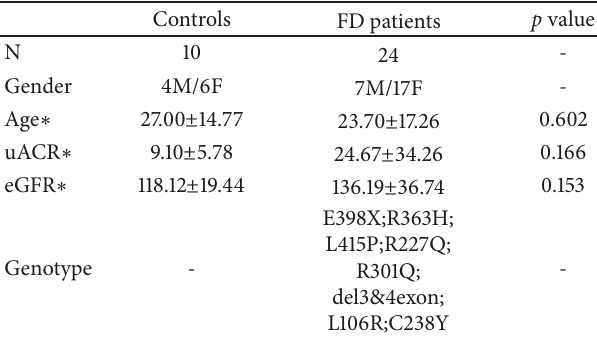
Table 1: Demographic characteristics of controls versus Fabry disease patients.